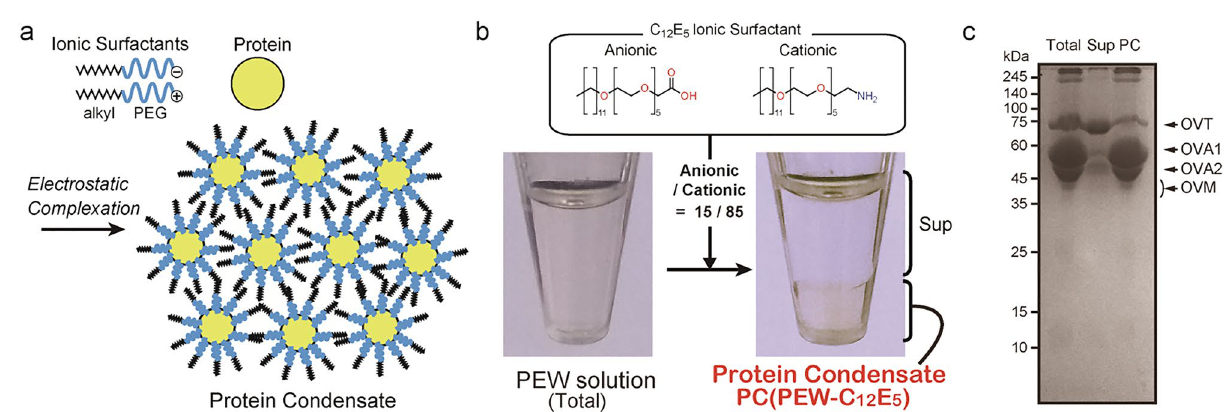
Figure 3. Protein condensate formation from pigeon egg white proteins ( a ) formation and structural model of protein condensate (PC) ( b ) PC from PEW proteins complexed with monodisperse cationic and anionic C 12 E 5 surfactants, termed PC(PEW-C 12 E 5 ). PC(PEW-C 12 E 5 ) is formed as a transparent fluid, phase-separated from the upper aqueous layer (Sup). ( c ) SDS-PAGE analysis of proteins in PC(PEW-C 12 E 5 ) (PC) and aqueous supernatant (Sup). “Total” indicates the PEW solution before adding surfactants. Major proteins are indicated (OVT, ovotransferrin; OVA1, ovalbumin 1; OVA2, ovalbumin 2; and OVM, ovomucoid) 15,16